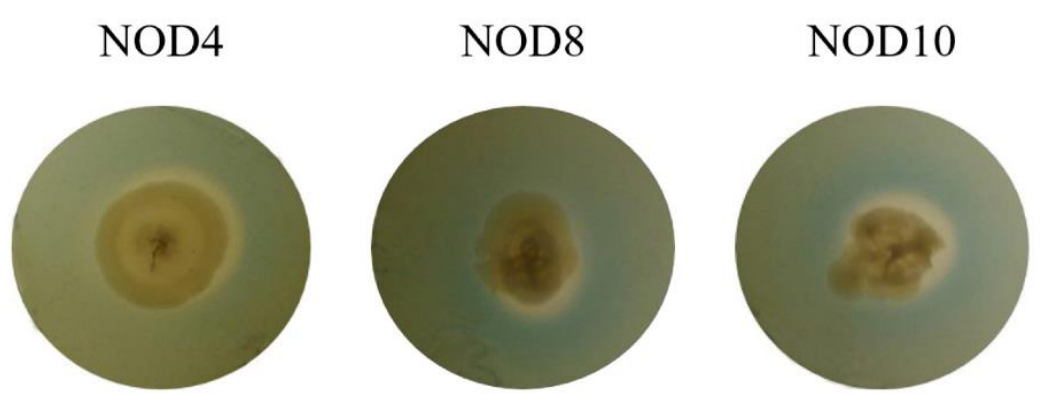
Figure 4. Determination of the production of siderophores in the three strains of Enterobacter . 2.6. In Vitro Evaluation of Enterobacter Strains against P. redivivus and N. aberrans The results of the evaluation of the strains of Enterobacter sp. NOD4 at a concentration of 1 × 10 9 cell/mL against the free-living nematode P. redivivus showed a mortality of 81.2%, E. mori (NOD8) of 72.4% and E. asburiae (NOD10) of 64.8% at 24 h (Table 2). The strain of Enterobacter sp. NOD4 against the nematode N. aberrans showed a mortality of 70.1%, E. mori (NOD8) of 62.5% and E. asburiae (NOD10) of 58.7% at 24 h (Table 3). Table 2. In vitro evaluation of Enterobacter strains against Panagrellus redivivus . Treatment Concentration